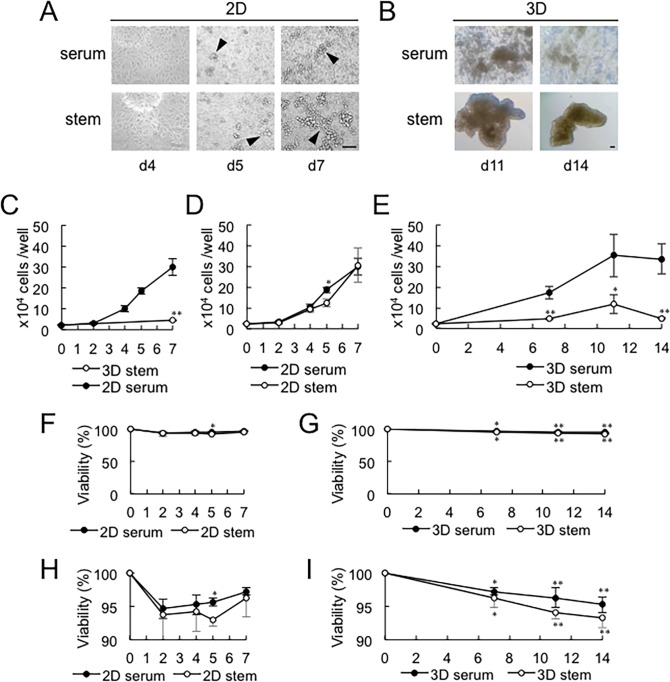
Enlargement of GLA due to slow cell proliferation and inter-gla fusion in the 3d stemness-inducing nanoenvironment.(A) Representative photomicrographs of PC-3 cells after reaching confluent. Cells were cultured in the 2D condition. Cellular morphologies at day 4, 5, and 7 were shown. Arrowheads indicate GLA on the 2D monolayer cells. Scale bar, 100 μm. (B) Representative photomicrographs of PC-3 cells in the 3D culture condition. Cellular morphologies at day 11 and 14 were shown. Scale bar, 100 μm. (C) Growth curves of PC-3 cells cultured in 2D serum-contained and 3D stem cell medium conditions. Cells were cultured in a 96-well plate. **P < 0.01 (2D serum vs 3D stem), n = 3. (D) Growth curves of PC-3 cells cultured in 2D serum-contained and 2D stem cell medium conditions. *P < 0.05 (2D stem vs 2D serum), n = 3. (E) Growth curves of PC-3 cells cultured in 3D serum-contained and 3D stem cell medium conditions. *P < 0.05 (3D stem vs 3D serum), n = 3. **P < 0.01 (3D stem vs 3D serum), n = 3. (F-H) Viabilities of PC-3 cells cultured in 2D or 3D conditions in serum-contained or stem cell media. Same data with different vertical axis values were shown between F and H and between G and I. (F, H) P < 0.05 (2D serum vs 2D stem), n = 3. (G, I) *P < 0.05 (vs day 0), n = 3. **P < 0.01 (vs day 0), n = 3. 3D serum d0 vs d7, P = 0.028. 3D serum d0 vs d11, P = 0.0052. 3D serum d0 vs d14, P = 0.0012. 3D stem d0 vs d7, P = 0.0138. 3D stem d0 vs d11, P = 0.0007. 3D stem d0 vs d14, P = 0.0004.